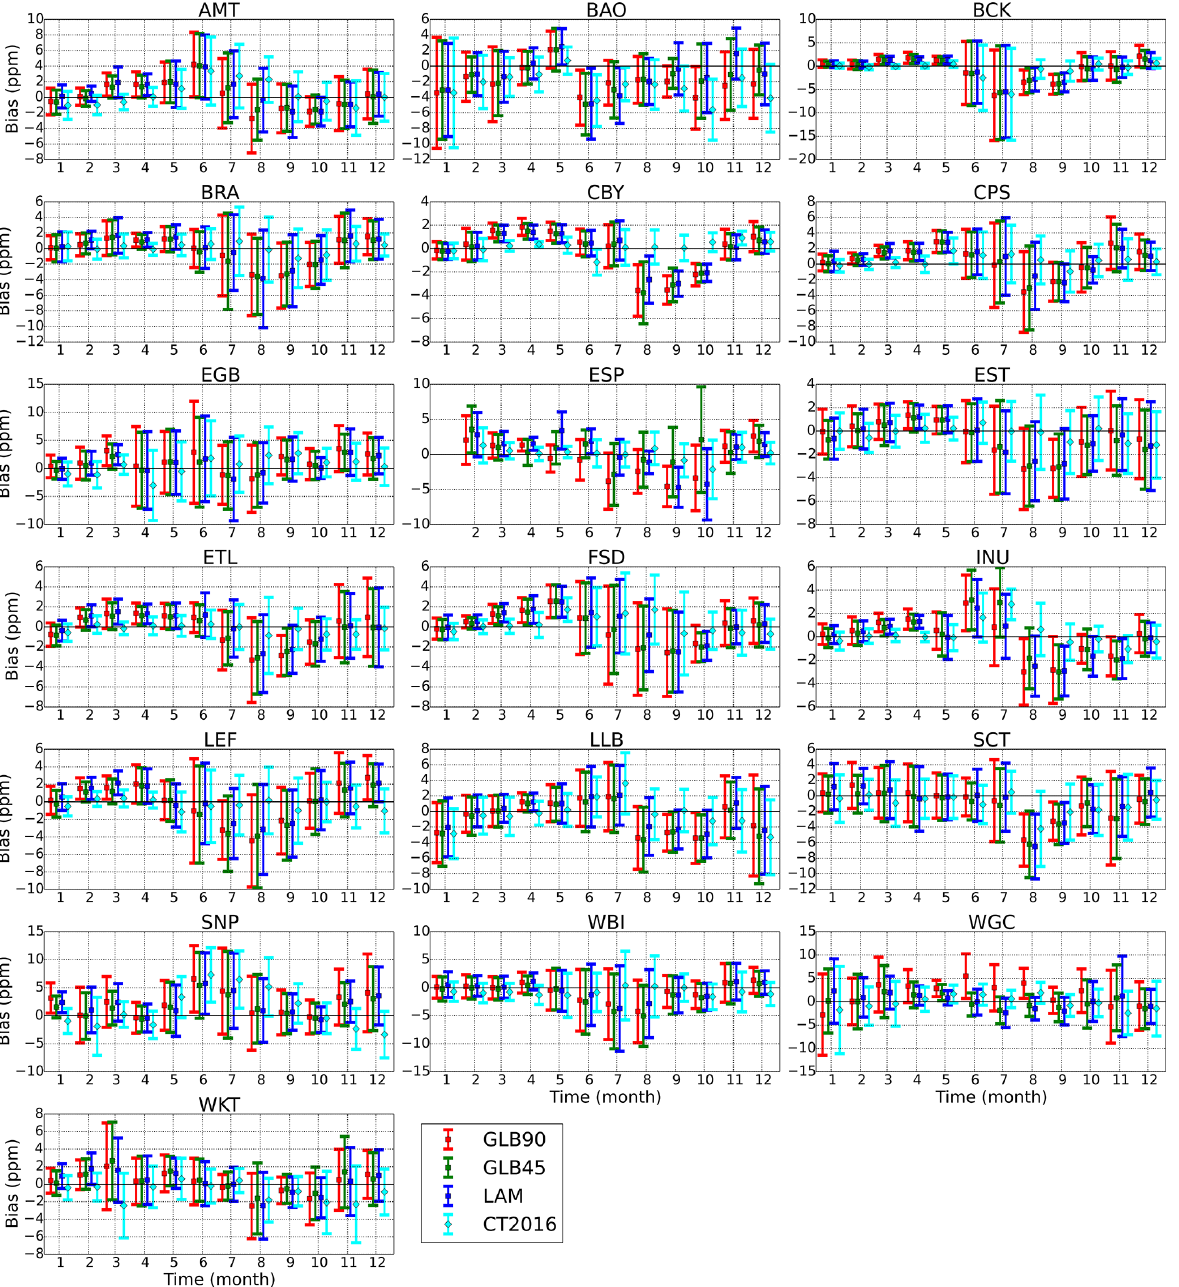
Figure 7. Monthly mean bias of daily afternoon averaged (12:00–16:00LST) CO 2 concentrations from the GLB90 (red), GLB45 (green) and LAM (blue) experiments as well as CT2016 (cyan) at all measurement sites used in this